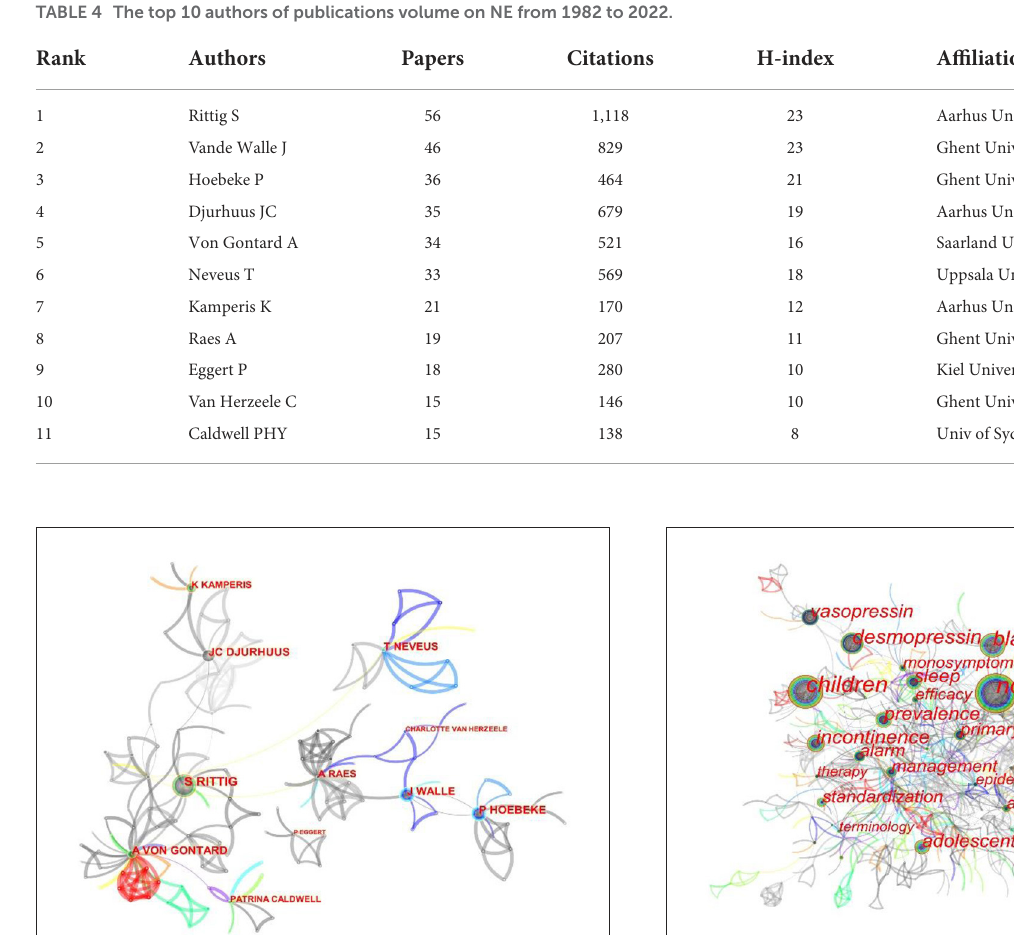
FIGURE6 Network of keywords occurrence on NE research. Each circle represents a keyword. The size of the circle is positively related to the frequency of the keyword, and the thickness of the line is positively correlated with the degree of association.